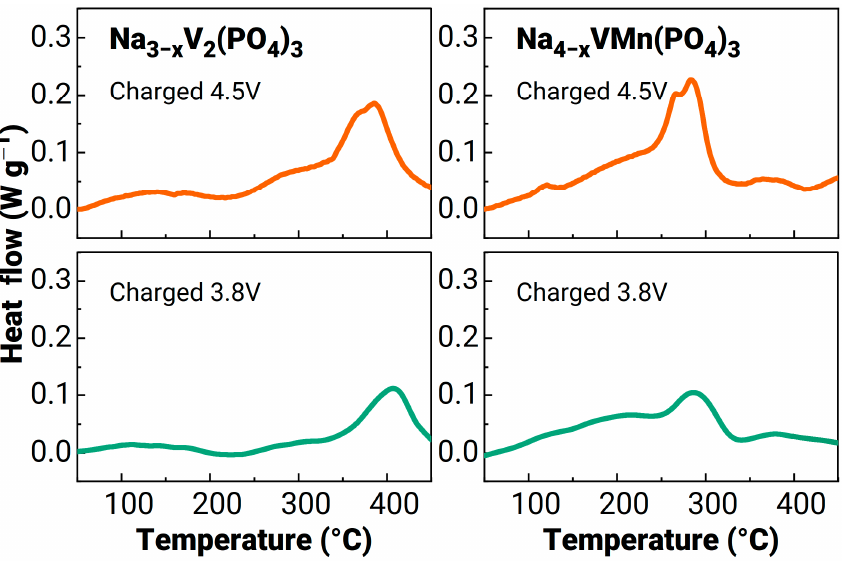
Table 1. Differential Scanning Calorimetry Data.